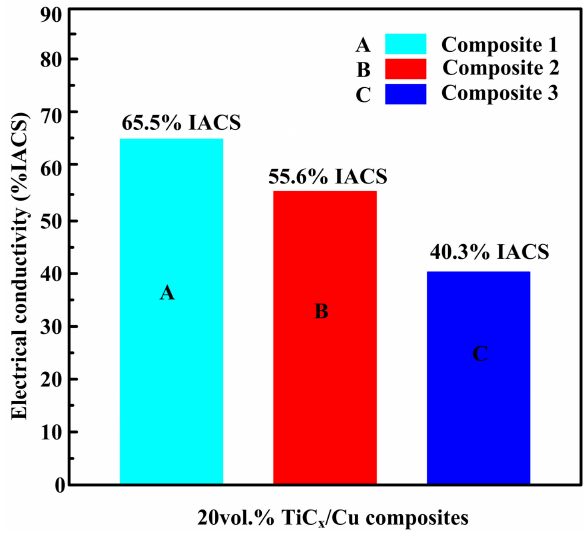
Figure 7. Electrical conductivities of composites 1, 2, and